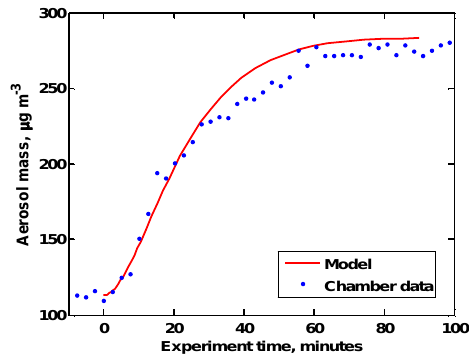
Figure 1. Aerosol mass loadings from IEPOX-SOA Exp. no. 1 and corresponding model output. IEPOX injection starts at experiment time t =